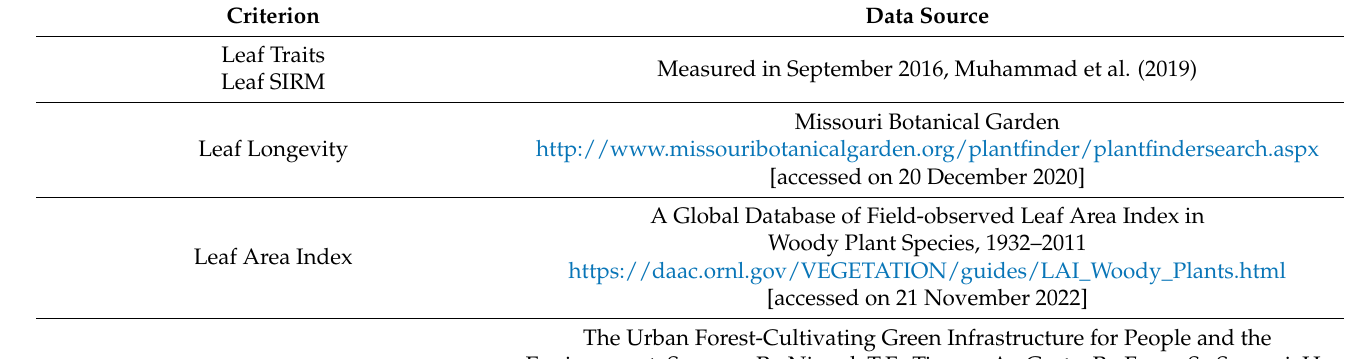
Table 1. Criteria and their data source to build the leaf traits, leaf SIRM, and services and disser- vices models. Data for leaf longevity, leaf area index, pollination, hardiness, invasive potential, and origin/native disease susceptibility available in open access. Data for leaf traits, leaf SIRM, drought tolerance, BVOC, allergenicity, food source, reduce urban heat island effect, and net carbon sequestration used with